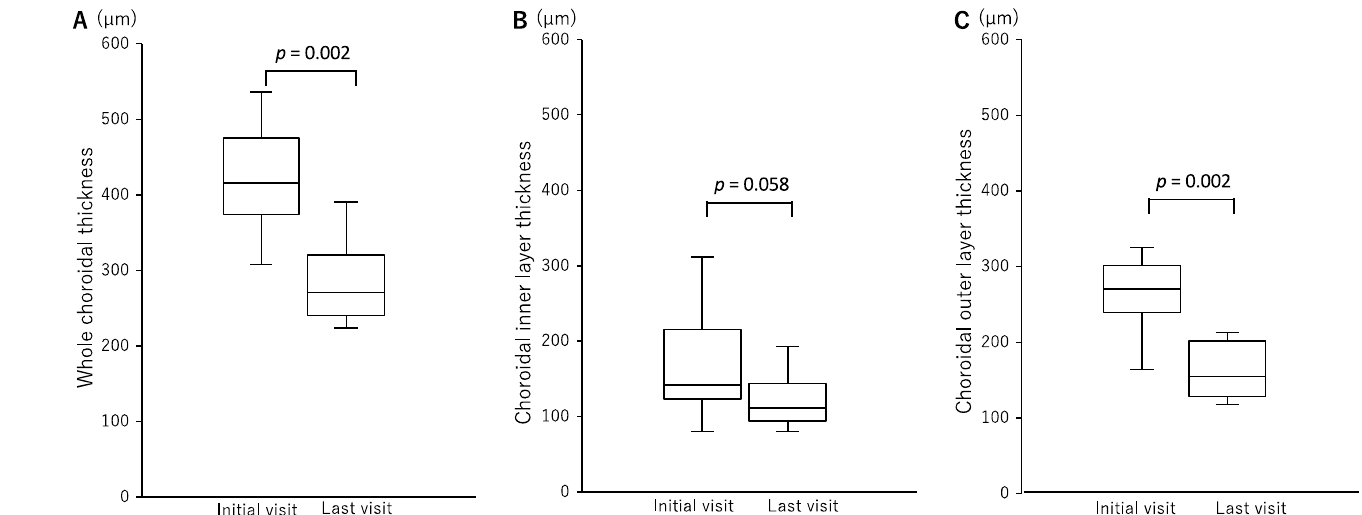
Figure 2. Graphs showing the comparative change in choroidal layer thickness between the initial visit and the last visit. Whole choroidal thickness ( A ) and choroidal outer layer thickness ( C ) significantly decreased at the last visit compared to those at the initial visit. There was no significant difference in choroidal inner layer thickness between the initial visit and the last visit ( B ).